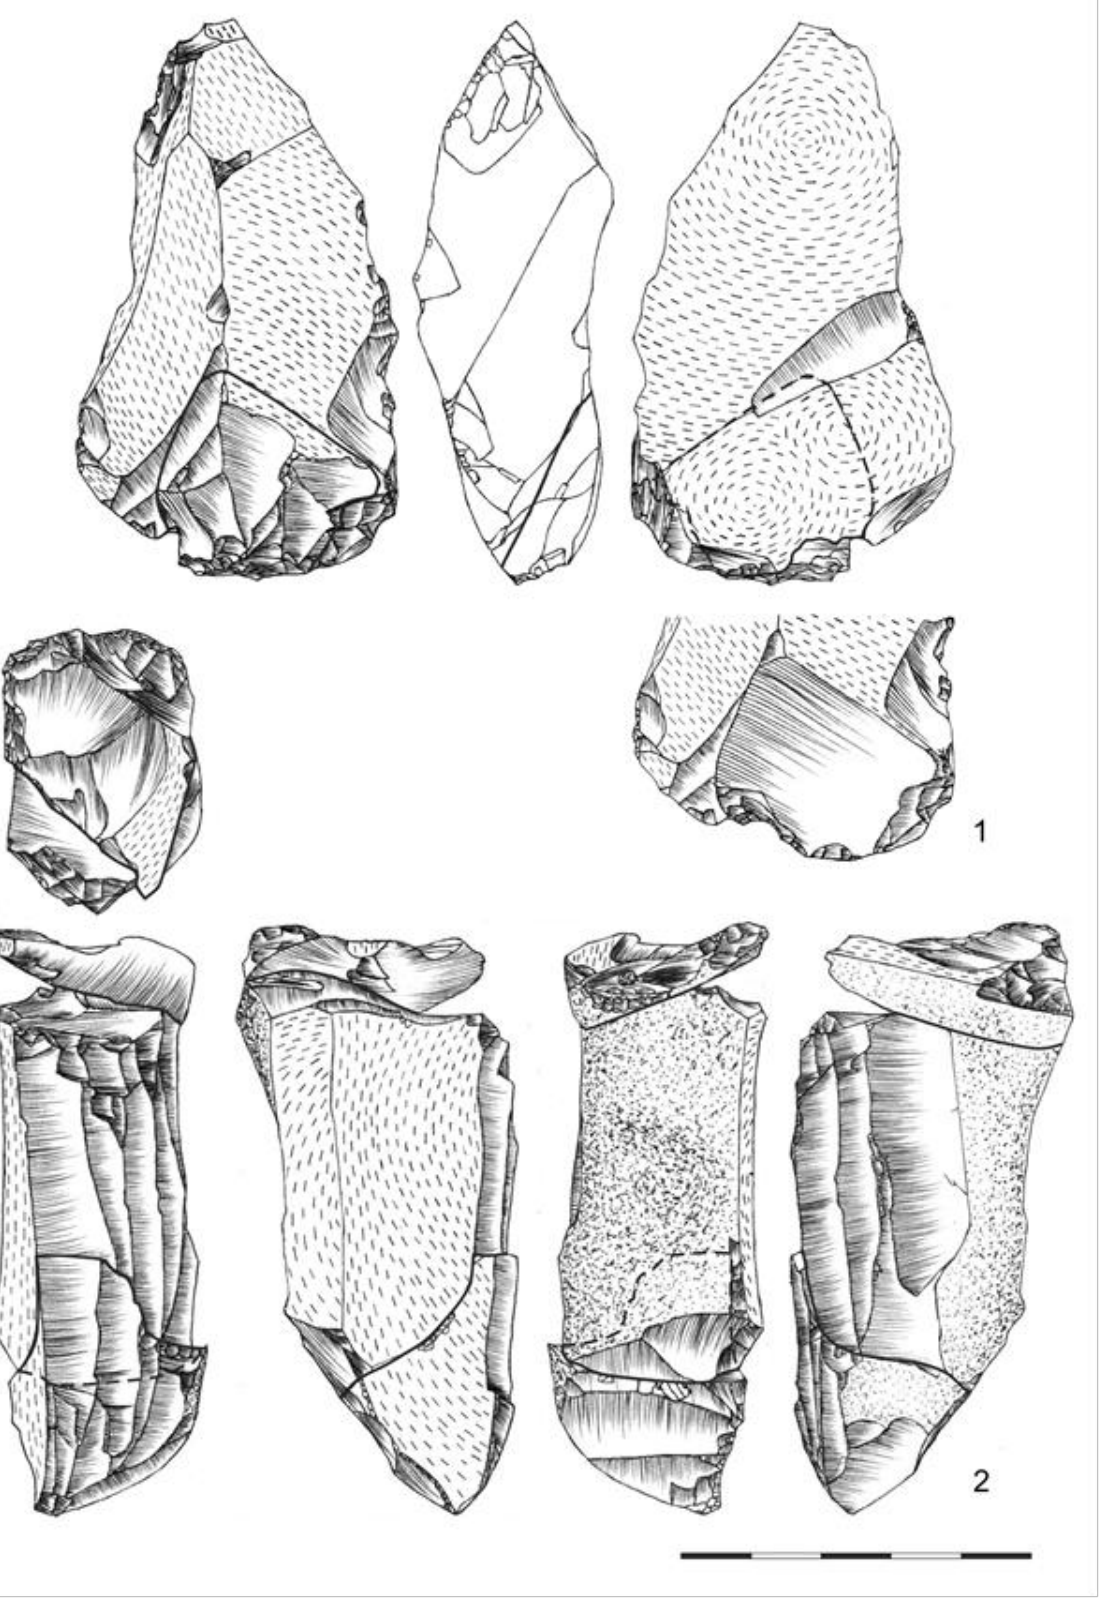
Figure 4. 1 – refit of a semi-product of a core axe blade with a flake forming the cutting edge; 2 – refit of a blade core with a flake forming the striking platform and a fragment of an overstruck blade from single platform core. Drawn by P.